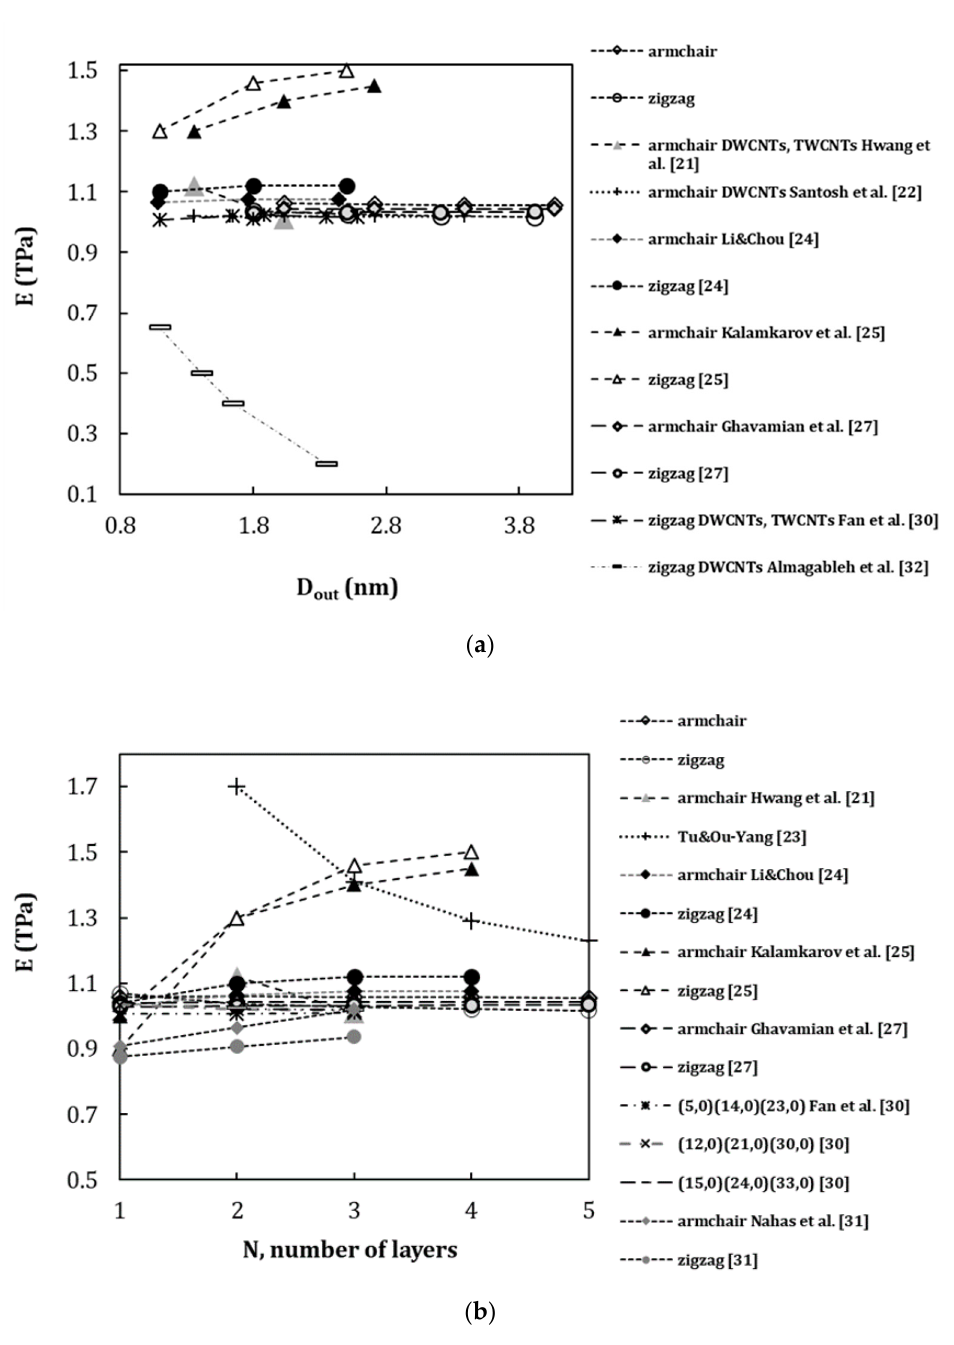
Figure 8. Comparison of the current results of the Young’s modulus with those reported in the literature as a function of: ( a ) outer layer diameter, D out , and ( b ) the number of layers, N , of the constituting MWCNT.